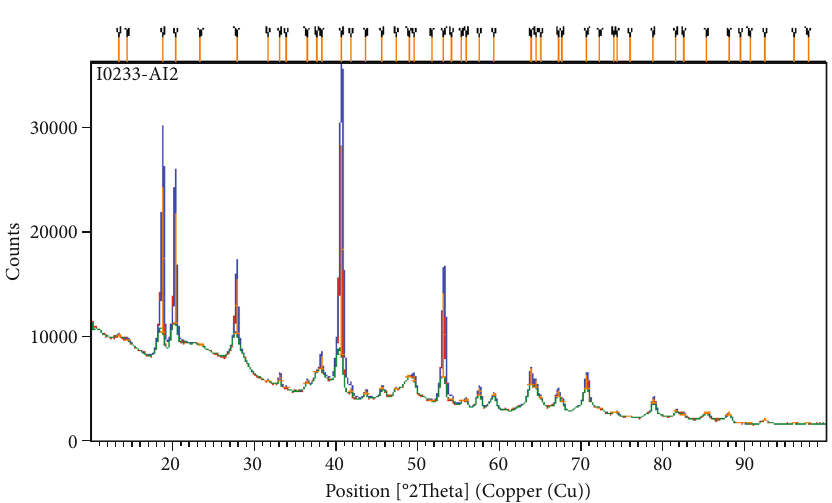
Figure 5: XRD of Al